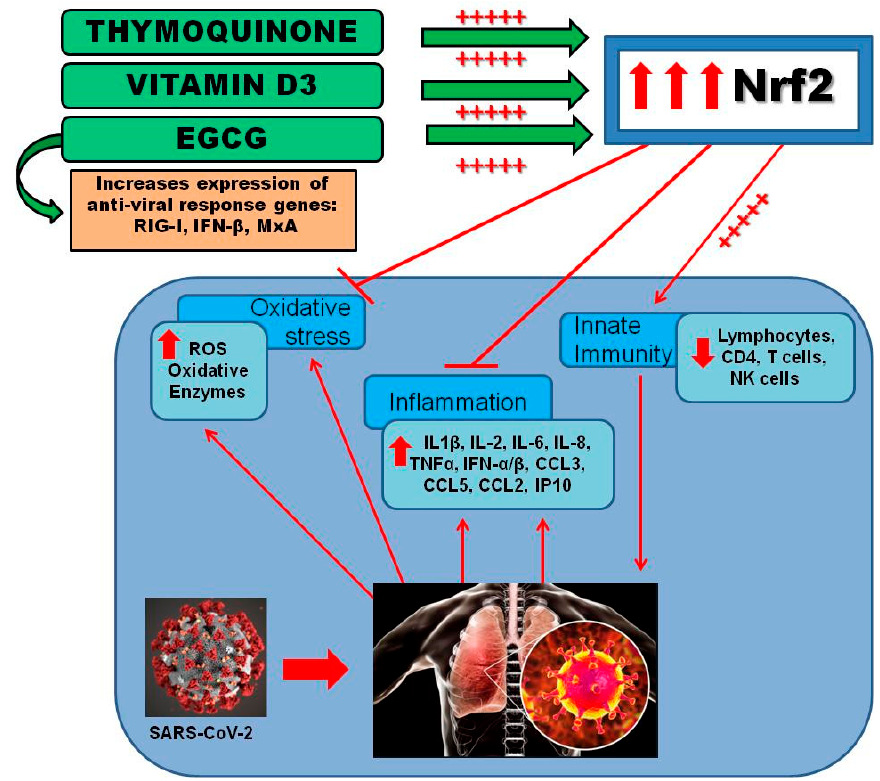
Figure 4. Suggested Nrf2 activation by the combination of EGCG, TQ, and vitamin D3. The diagram shows the activation of Nrf2 by EGCG, TQ, and vitamin D3 given in combination, reducing oxidative stress, inflammation, and stimulating innate immunity as a way to prevent or modulate SARS-CoV-2 infection.